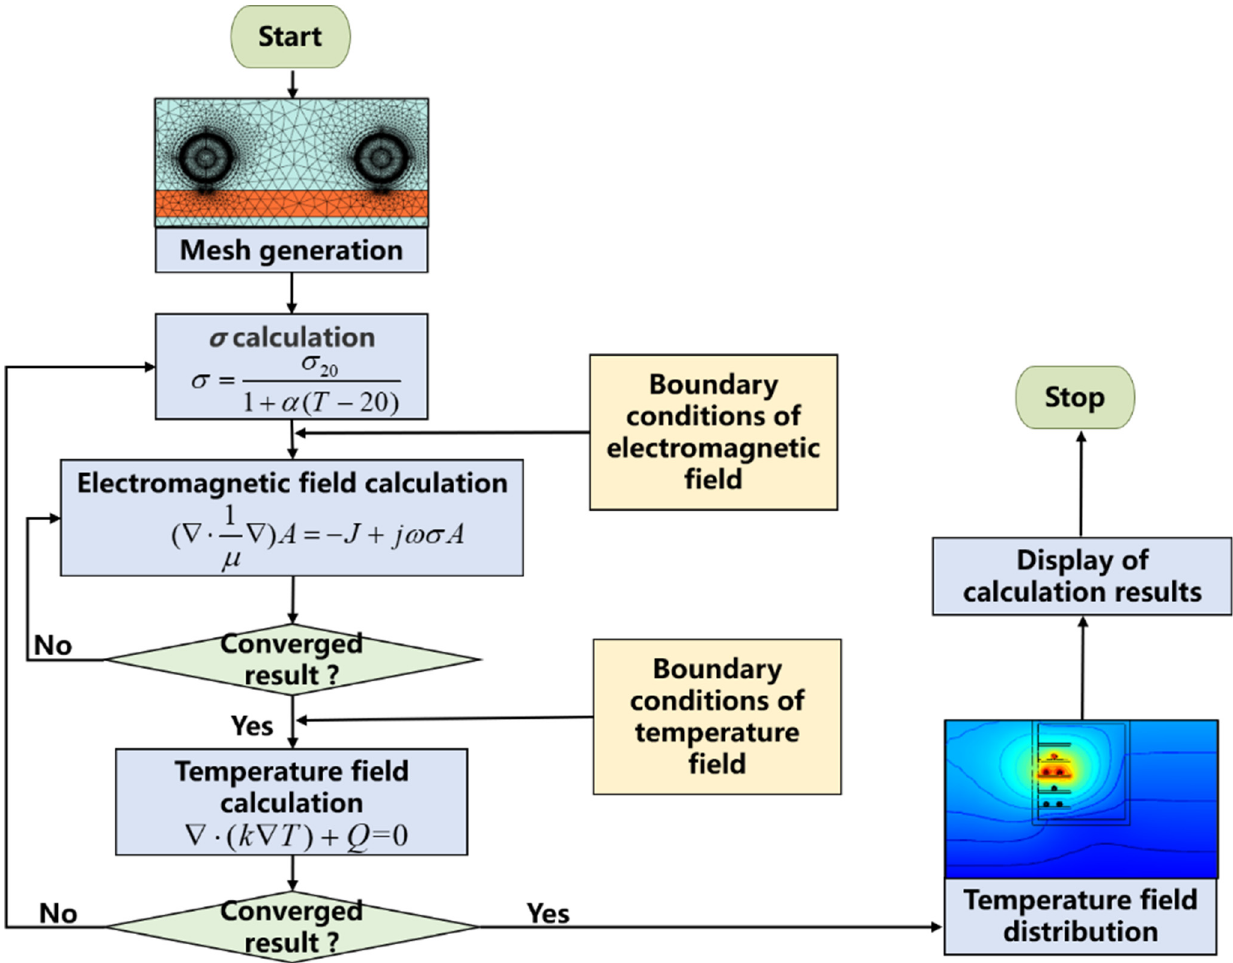
Figure 1. A flow chart of the conductor temperature